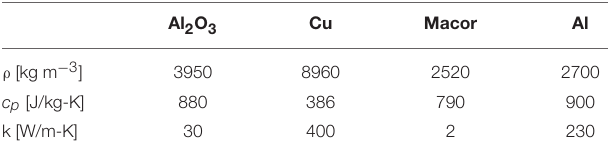
TABLE 1 | Thermal properties of Pocket Rocket component